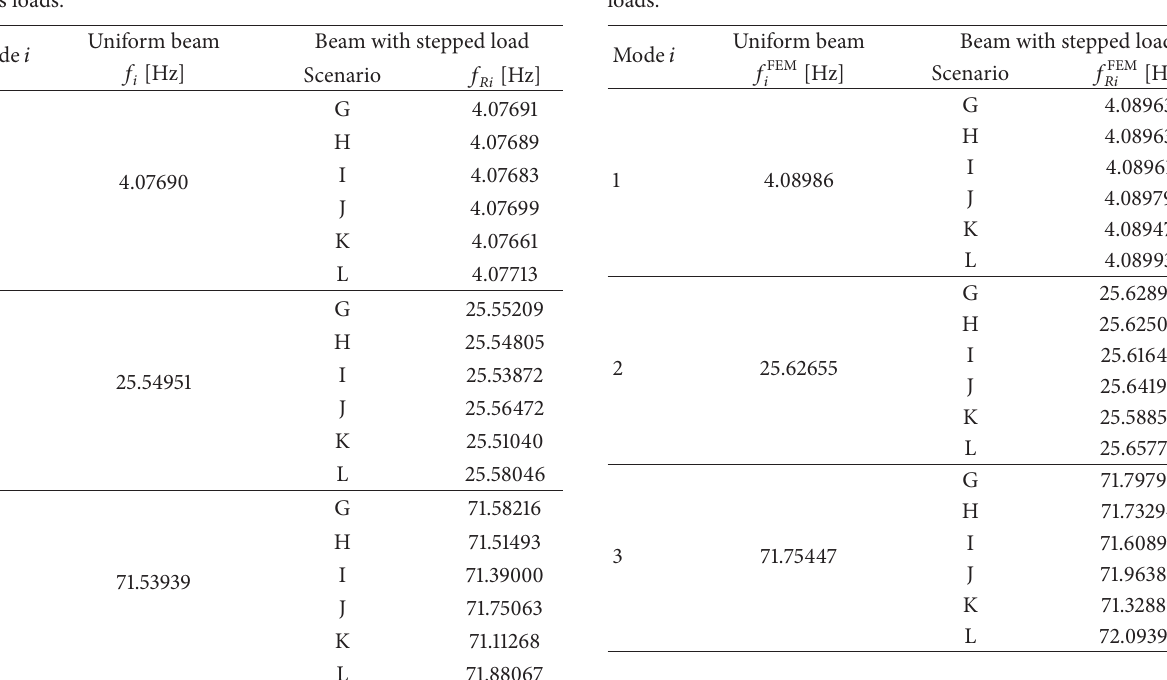
Table 6: Natural frequencies found by FEA for concentrated mass loads.